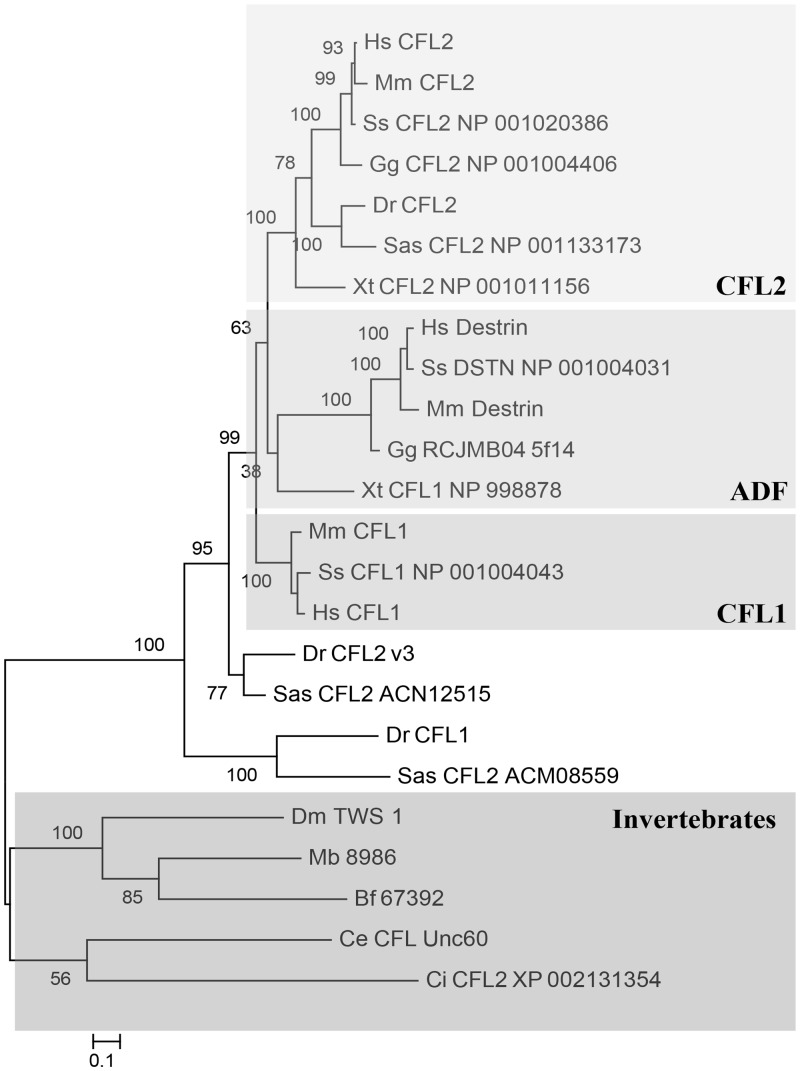
Bayesian phylogenetic analysis of the animal ADF/CFL gene family.The three ADF/CFL classes are highlighted in boxes. Species designation are as follows: Hs, Homo sapiens; Mm, Mus musculus; Ss, Sus scrofa; Gg, Gallus gallus; Xt, Xenopus tropicalis; Dr, Danio rerio; Sas, Salmo salar; Bf, Branchiostoma floridae; Ci, Ciona intestinalis; Dm, Drosophila melanogaster; Ce, Caenorhabditis elegans; Mb, Monosiga brevicollis. ADF/CFL family number is given next to species designation when available. For those sequences that did not have a published family number on NCBI, the accession number is given. Accession numbers for all animal ADF/CFL variants used in analyses can be found in S2 Table.